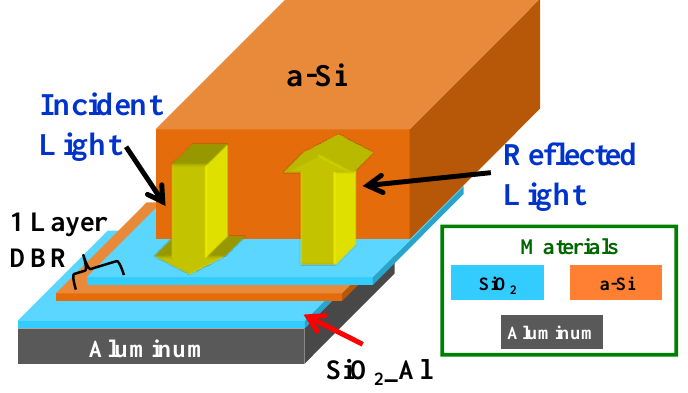
Figure 1. Design schematic showing the basic premise of the work presented in this paper. The idea is to find a high performance back surface reflector with few dielectric layers. The light is incident on the back reflector through a semi infinite a-Si